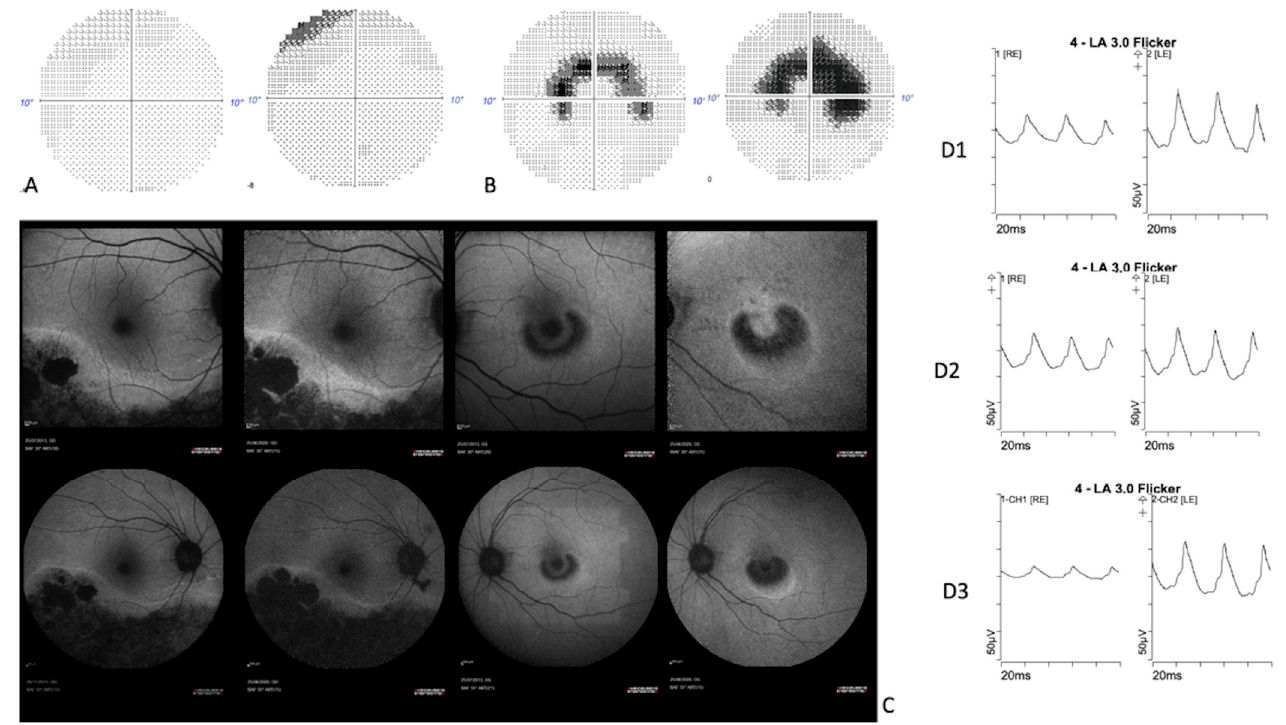
Figure 4. A seven-year follow-up comparison between: LE10-2 SITA fast Humphrey visual field ( A ); RE 10-2 SITA fast Humphrey visual field ( B ); 55° fundus autofluorescence, 32°fundus autofluores- cence ( C ); flicker responses extracted from ISCEV full-field ERG in 2013 ( D1 ), 2015 ( D2 ) and 2020 ( D3 ). The seven-year follow-up showed a slow progression of anatomical and functional alterations.